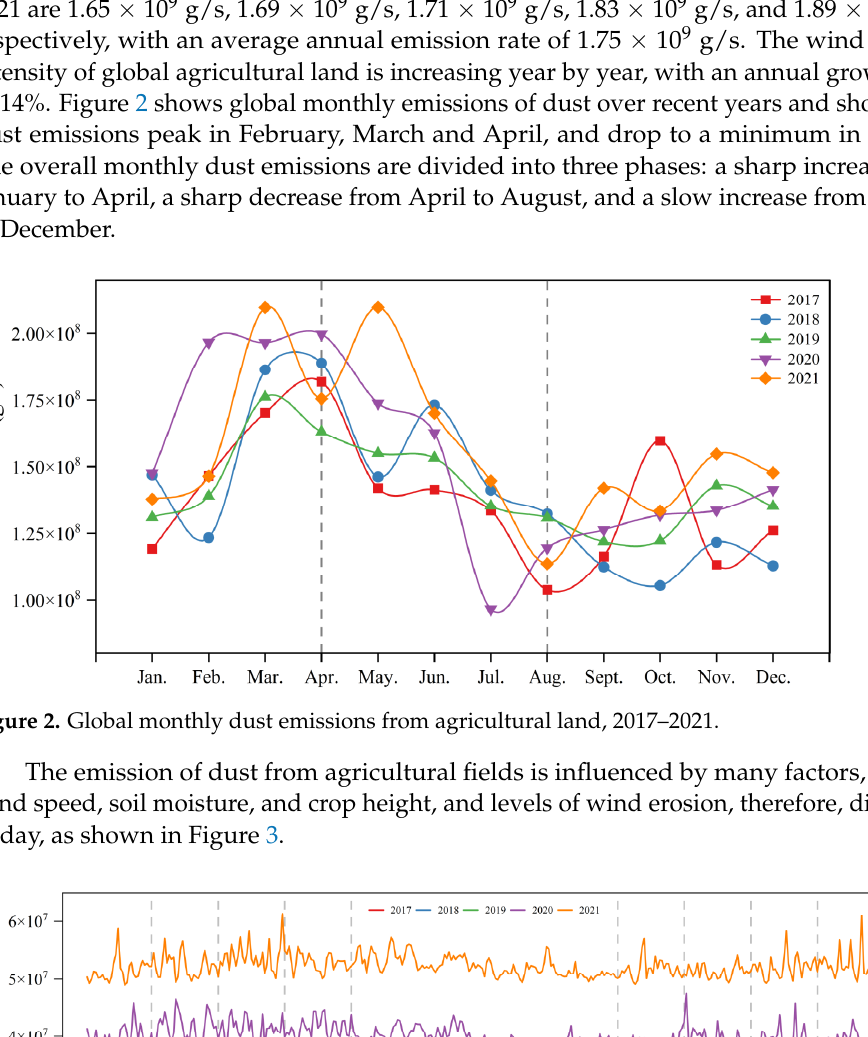
Figure 3. Global daily dust emissions from agricultural land, 2017–2021. Note: 1–365 or 366 for Jan- uary 1st to December 31st of each year.